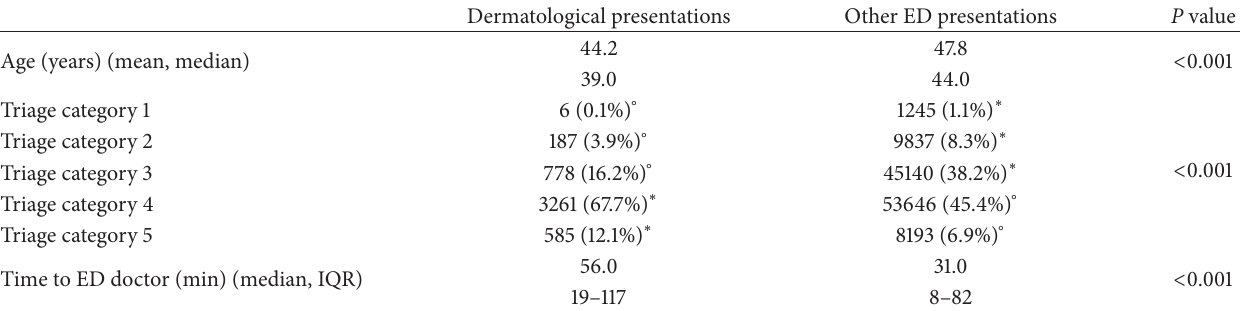
Table 1: Demographic data for dermatological presentations compared to nondermatological presentations to ED.